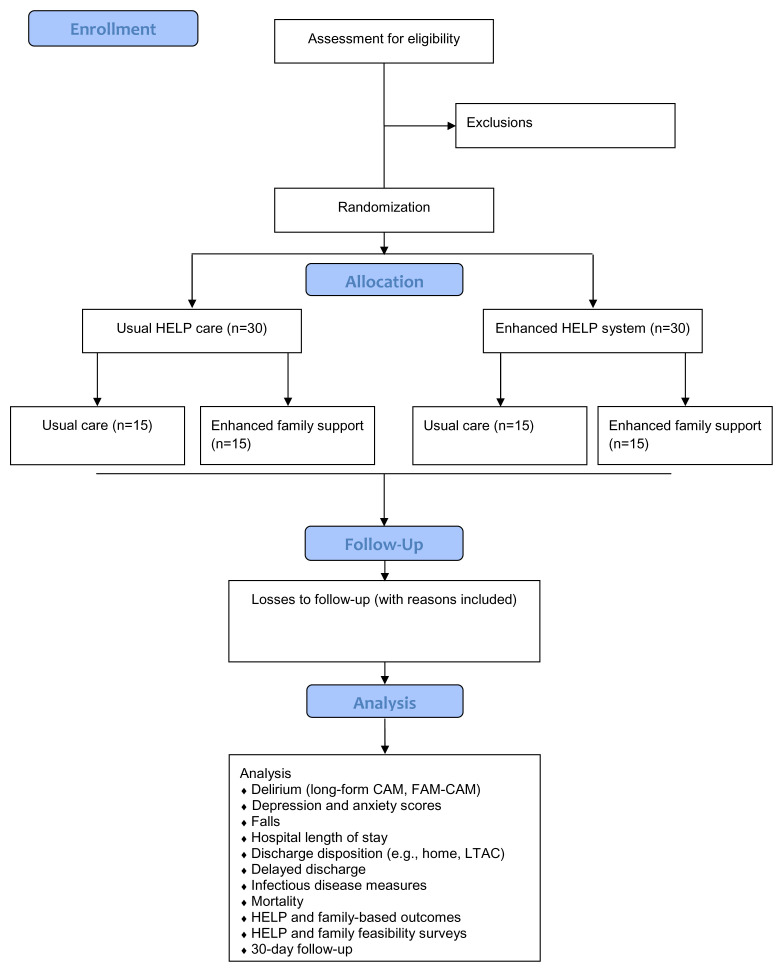
CONSORT study flow diagram.HELP = Hospital Elder Life program; CAM = Confusion Assessment Method, LTAC = Long-Term Acute Care.